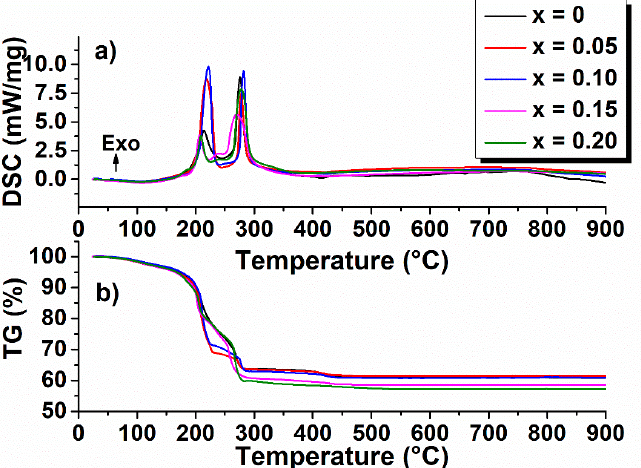
Figure 1. ( a ) Differential scanning calorimetry (DSC) and ( b ) thermogravimetry (TG) curves of Figure 1. ( a ) Di ff erential scanning calorimetry (DSC) and ( b ) thermogravimetry (TG) curves of Bi 1 − x Eu x FeO 3 xerogels. Bi 1 − x Eu x FeO 3